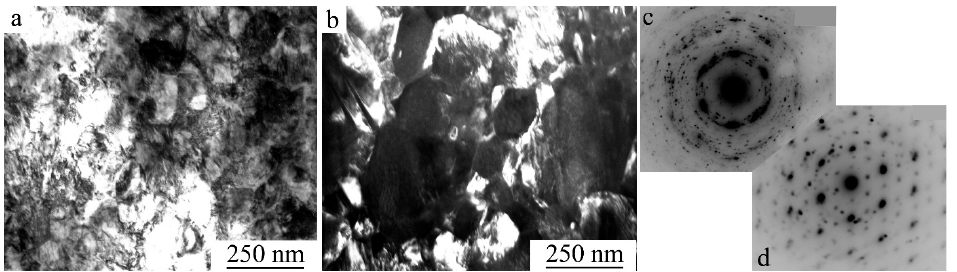
Figure 25. ( a ) Bright- and ( b ) dark-field TEM images, and ( c , d ) SAED patterns (( c )—SD 1.0 µm, ( d )—z.a. close to [111] В 2 || [110] B 19’ , SD 0.3 µm), taken from the Ti 49 Ni 51 alloy after MPR by 30% and PDHT at 673 К 1 for h. Arrows show particles of Ti 4 Ni 2 O x .